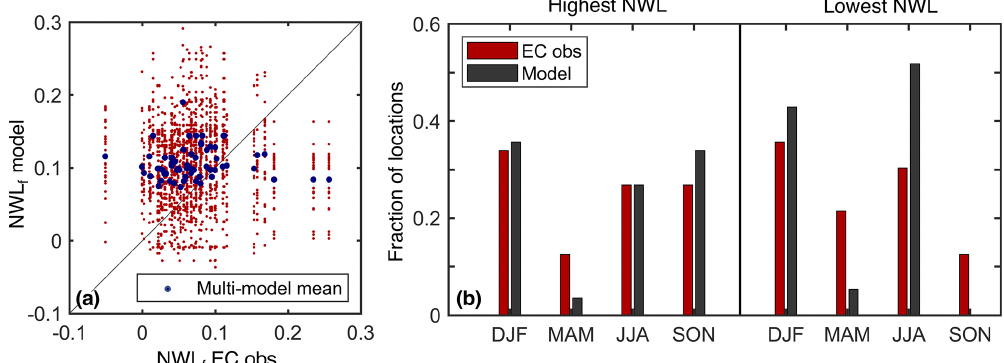
Figure 9. Comparison of observations with climate model simulations at the corresponding grid cells. (a) NWL f from EC observations vs. model simulations at 64 locations. (b) Fraction of the 56 locations (i.e., FLUXNET sites or grid cells) above 30 ◦ N where each season has the highest or lowest NWL on average. Seasons are defined by the following trimesters: December–February (DJF), March–May (MAM), June–August (JJA), and September–November